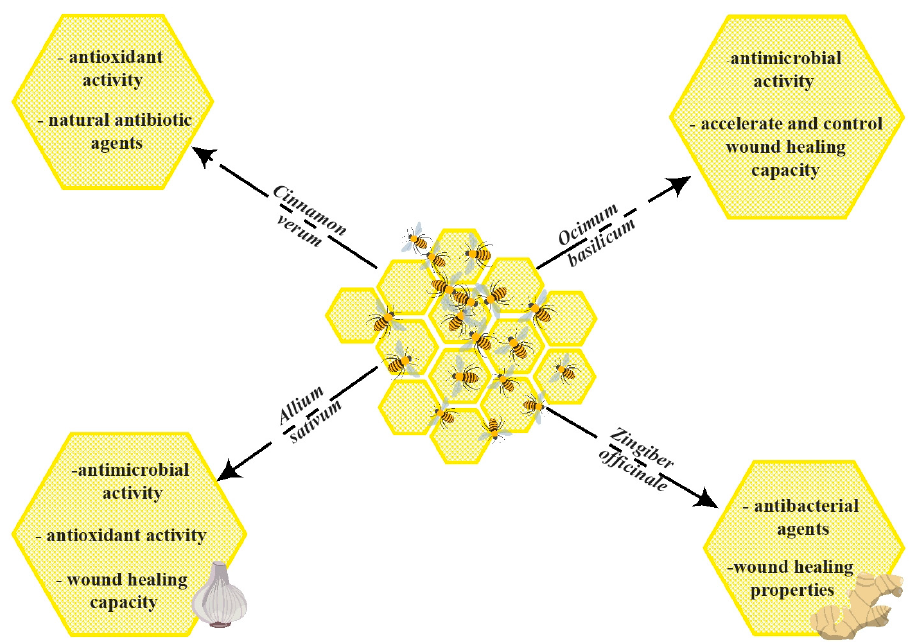
Figure 2. The synergic effect of honey with medicinal plants. The figure was designed with ConceptDraw Diagram 16.